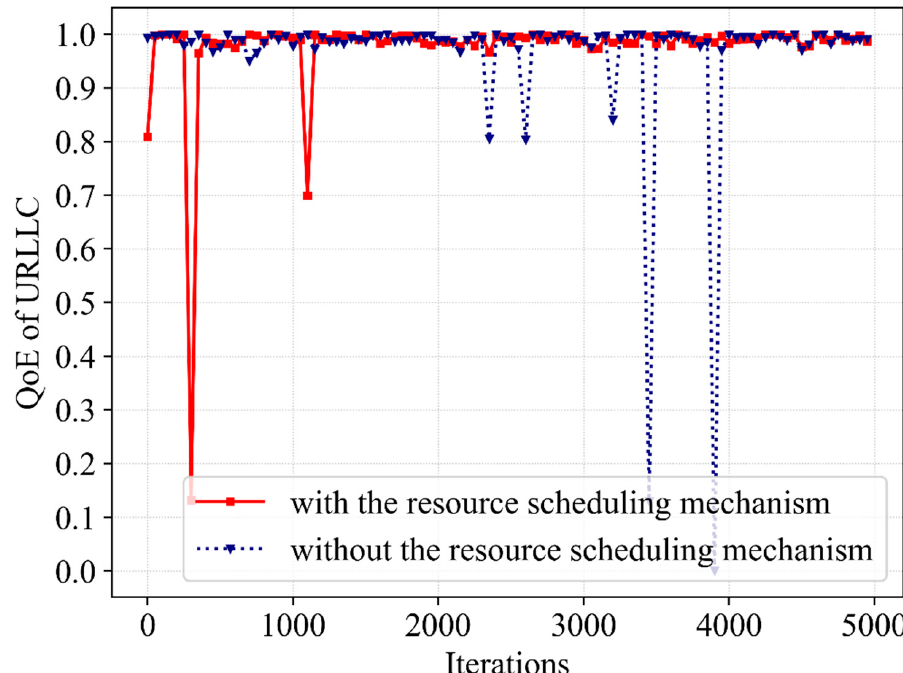
Figure 8. A comparative result of QoE for URLLC service with and without the resource scheduling mechanism.